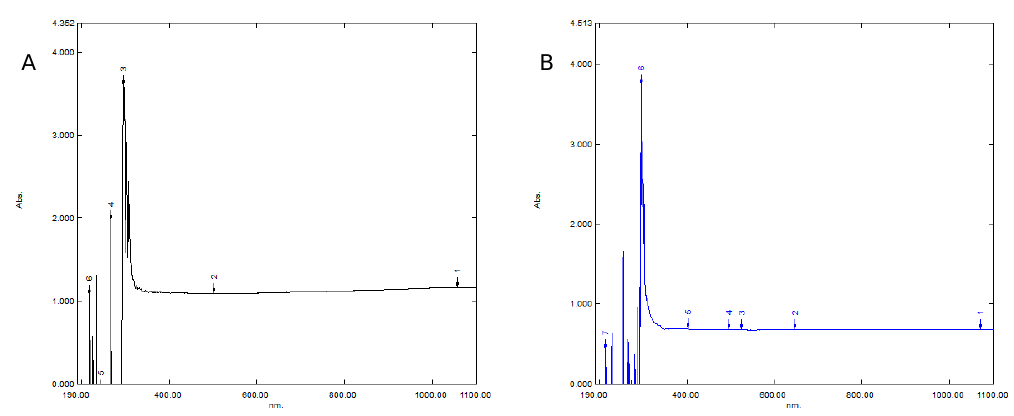
Figure 2. Set structure for the laser irradiation on maize seeds.